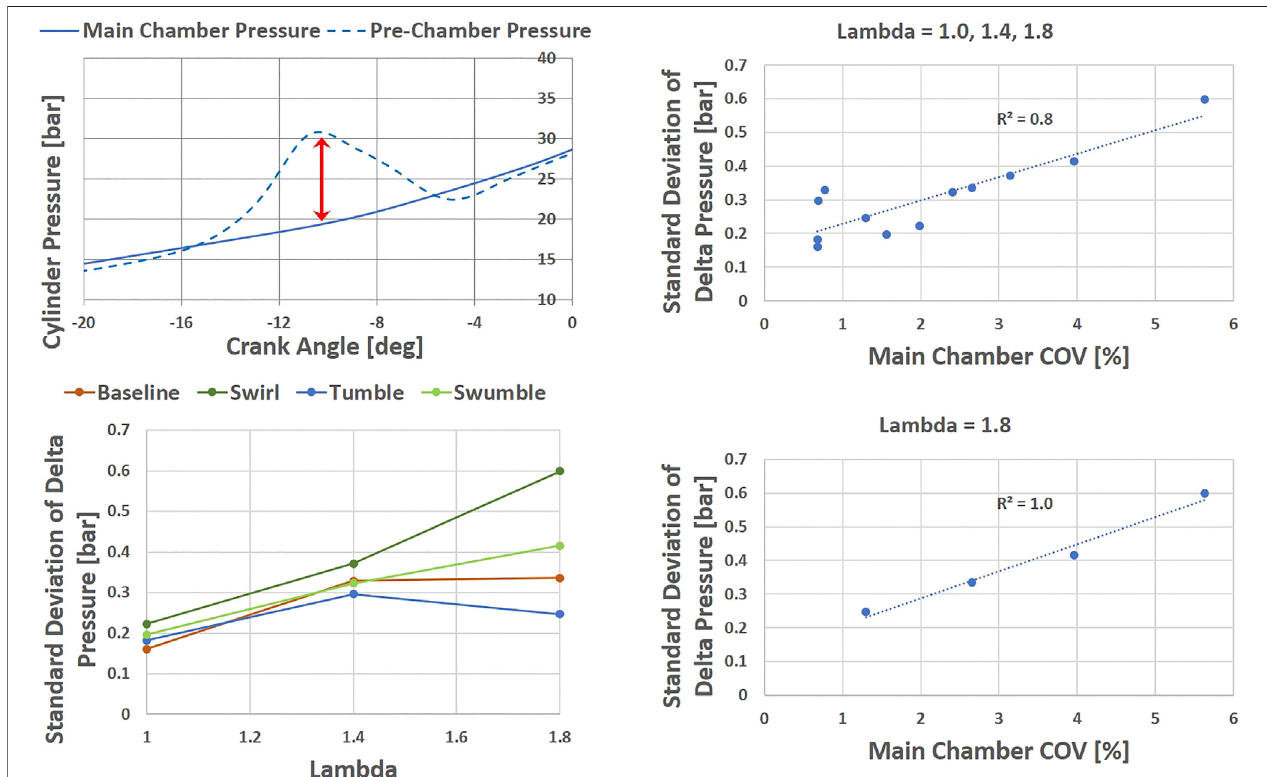
FIGURE 9 | Pre-chamber combustion metrics: illustration of chamber delta pressure (top left) ; standard deviation of delta pressure vs. lambda (bottom left) ; standard deviation of delta pressure vs. main chamber COV for lambda (cid:1) 1.0 – 1.8 (top right) ; standard deviation of delta pressure vs. main chamber COV for lambda (cid:1) 1.8 (bottom right)